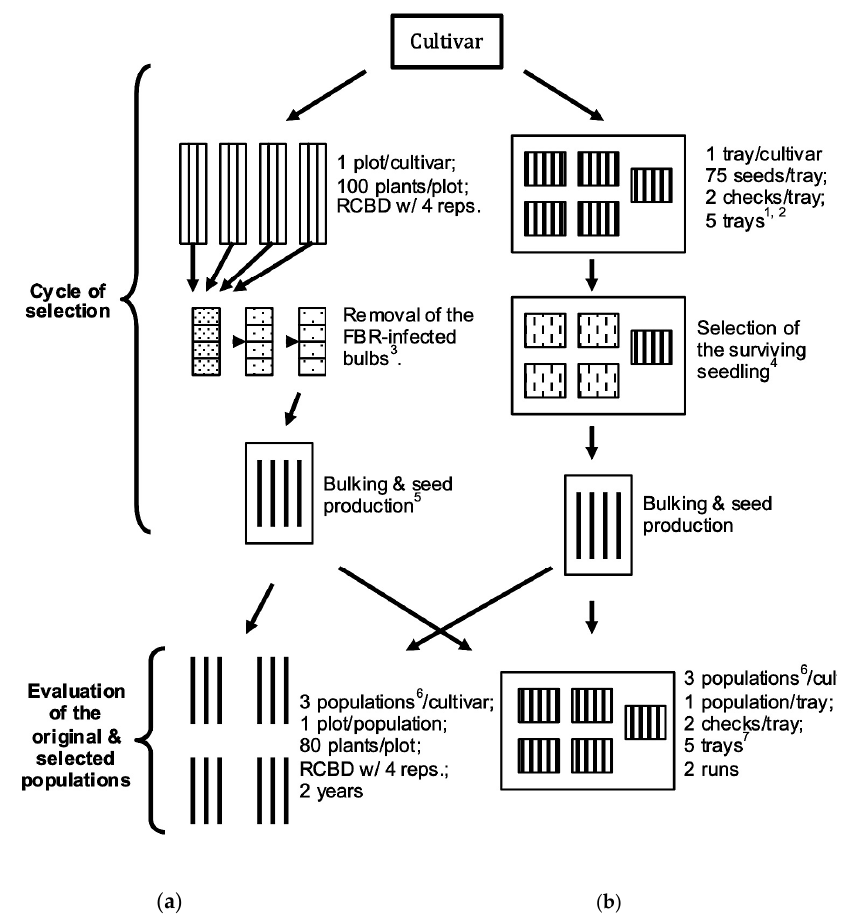
Figure 1. Flow chart of selection cycle and evaluation of a cultivar population via ( a ) Mature Bulb Selection (MBS) in a naturally FOC-infested field, and ( b ) Seedling Selection (SS) in a growth chamber for improving FBR resistance in onion. 1 Four trays were inoculated with fungal inoculum; 2 A fifth tray was irrigated with equal amount of distilled water. 3 FBR-infected bulbs were discarded at harvest, 4 weeks after harvest, and before seed production. 4 Small bulbs were produced before being transplanted into the field. 5 Onion is a biennial crop that requires bulb production in between seed production to complete its life cycle. All the selected bulbs were bulked into a single cage for seed production. 6 In both evaluations original, mature bulb-screened and seedling-screened populations were planted in each replication. 7 Four trays were inoculated, and a fifth tray was uninoculated.